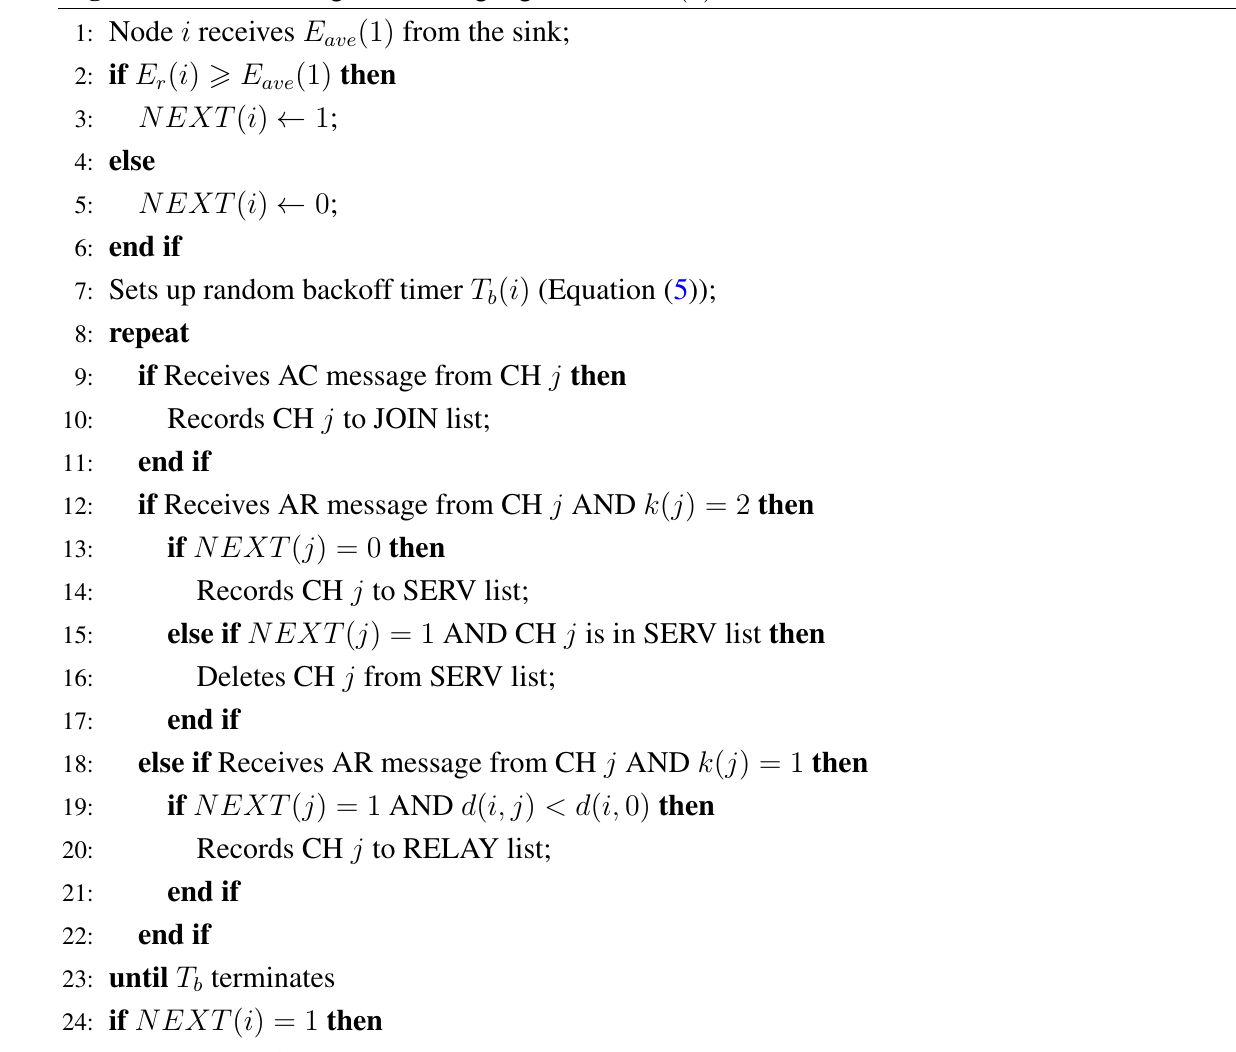
Algorithm 1 Clustering and routing algorithm in R (1)